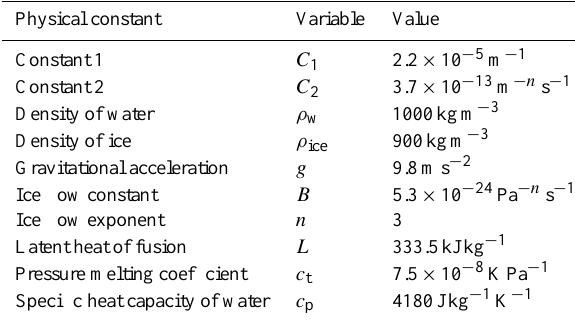
Fig. 2. The lumped element model consisting of a moulin element (left) and a channel element (right). It is driven by the measured dis- charge into the moulin Q m and the proglacial discharge Q p . Note that the additional discharge Q a , required for conservation of water mass, is not of interest for our purposes and is not calculated.